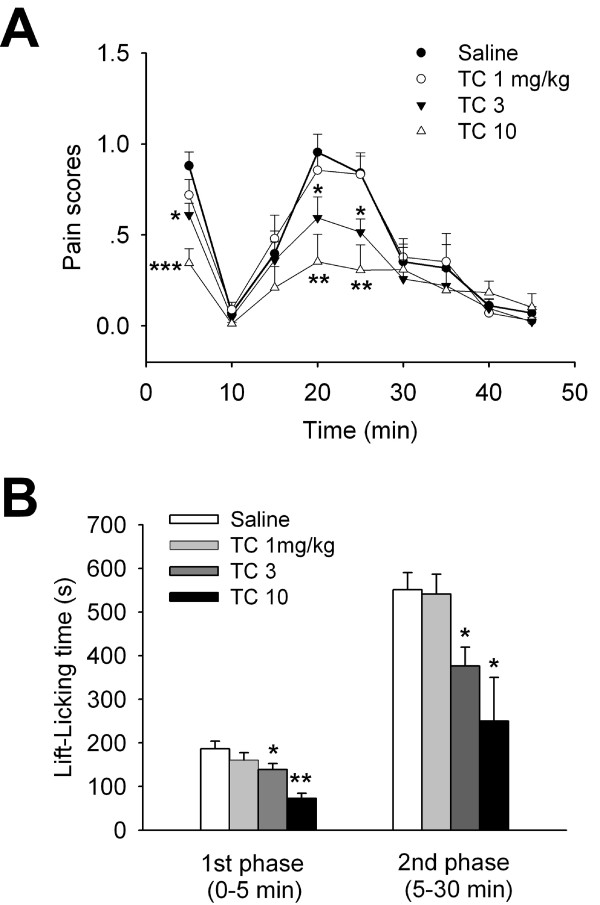
Effect of TC-2559 on formalin-induced biphasic nociceptive responses in mice. A, Traces showing intraperitoneal injection of TC-2559 (1, 3, 10 mg/kg) dose dependently suppressed formalin induced progressive biphasic pain behavior score; B, Bar histogram showing the group data of antinociceptive effect of TC-2559 on formalin induced paw lift-licking time in both early 1st phase (0-5 min) and late 2nd phase (5-30 min) of mice formalin model. *P < 0.05, **P < 0.01 compared with vehicle saline control (two-way ANOVA followed by the Holm-Sidak test).